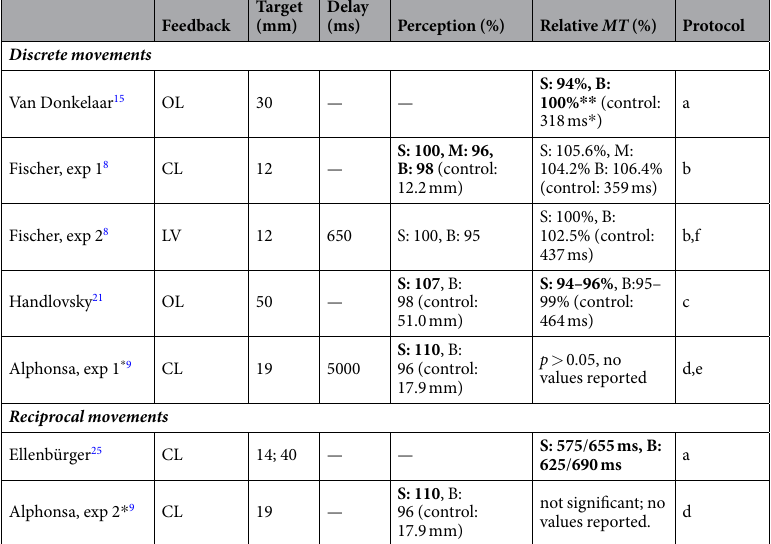
action were equally affected by visual illusions and thus concluded that the same representation of object size guides perception and action 10–15 . These contradictory findings and interpretations are opposed by authors claim- ing that the illusion effects do not depend on whether the task is perceptual or motor, but rather on the spatial attributes that are used to execute a task 16, 17 . For example, in the same movements the lift and grip force are sensi- tive to a size illusion, but grip aperture is not 18, 19 . Yet another view was forwarded by Glover 20 , who proposed that visual illusions affect the planning of actions, but not their on-line control 20 . Since experimental support exists for each of the aforementioned approaches, numerous methodological differences suggest that a clear interpretation of the repeatedly contradictory results will be impossible unless systematic and well-parameterised experimental studies disentangle the role of the visual system in perception and action. One task that has been implemented to test whether the visual system is functionally dissociated, is Fitts’ task 9, 15, 21, 22 . In a Fitts’ task, a participant is asked either to move a stylus on a tablet from a start position to a given target of width ( W ) and distance ( D ) (i.e., single or discrete movement) or to cyclically move between two targets of width ( W ), which are separated by a distance ( D ). By systematically varying D and W , Fitts 23 linearly related the movement time ( MT ) to the ratio of movement distance ( D ) to target width ( W ) through the index of difficulty ID = log 2 (2 D / W ) by MT = a + b ID . The index ( ID ) expresses the difficulty of the task in bits 23, 24 . The robustness and insensitivity to experimental contexts of this so-called Fitts’ law, as well as it quantitative nature, render Fitts’ paradigm a powerful tool to investigate the dissociation of visual streams. The question arises whether the linear relationship between the MT and the ID is affected by a visual context. It is unknown what the effect on the MT is when the subjective target size (i.e., perceived W ) is smaller, or bigger, than it physically is. Therefore, Ebbinghaus-like figures have been implemented in Fitts’ tasks to investigate the effect of perceptual illusion on motor behavior 8, 9, 15, 21, 25, 26 . The results of these studies, however, show many contradictions. Van Donkelaar 15 was the first to find an effect of the Ebbinghaus illusion on discrete movements in a Fitts’ task, by showing an increase in MT when the targets looked smaller (or at least, were thought to have looked smaller; see below). Later, Fischer, however, failed to reproduce these findings in a similar task and reported an insensitivity of the movements to the Ebbinghaus-like figure 8 . Up to now, to our best knowledge, Fischer’s study remains the only discrete Fitts’ task that failed to show an effect of visual illusions on movement time. Indeed, several studies found that pointing movements were affected by the visual illusion (see Table 1 for a summary of the results of these studies). In one study movements were found to be faster towards bigger looking targets 21 . This contrasts yet another study that showed MT to remain unaffected by a combined Ebbinghaus-Müller-Lyer figure. However, precision and amplitude for a certain effective ID resembled the perceived ID in a discrete Fitts’ task 9 . Thus, the discrete pointing tasks have rendered ambiguous results.